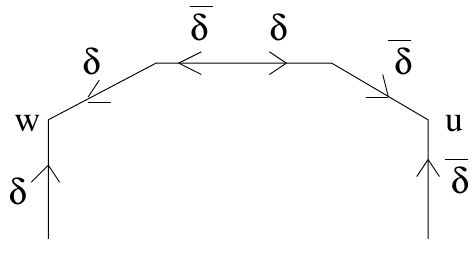
Figure 17 . Skeleton graph for (cid:8) 23 ;A